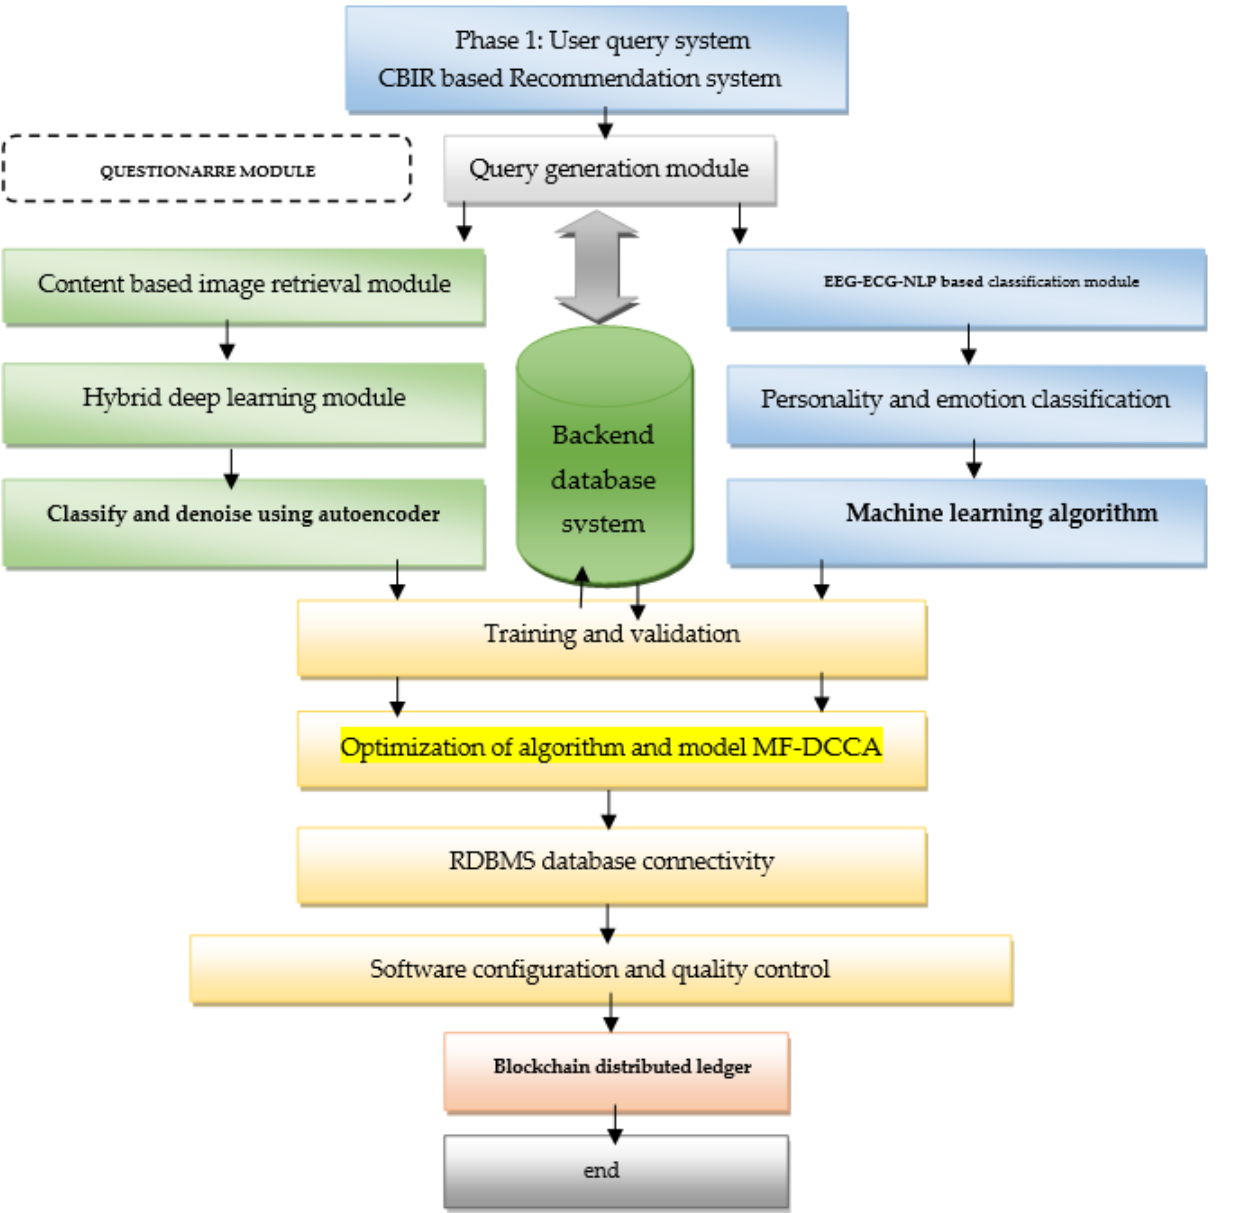
Figure 2. Flowchart for content-based recommendation model.